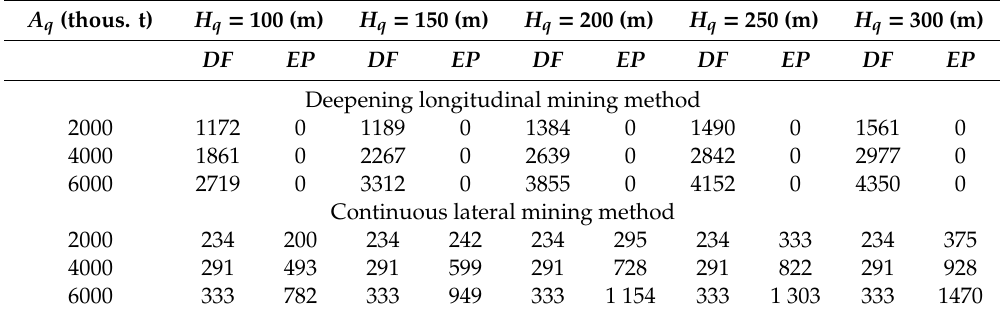
Table 5. Costs on overburden transporting (thousand USD): diesel fuel ( DF ) and electricity power ( EP ) consumption, in accordance with selected mining method, pit depth ( H q ) and annual capacity ( A q , thousand